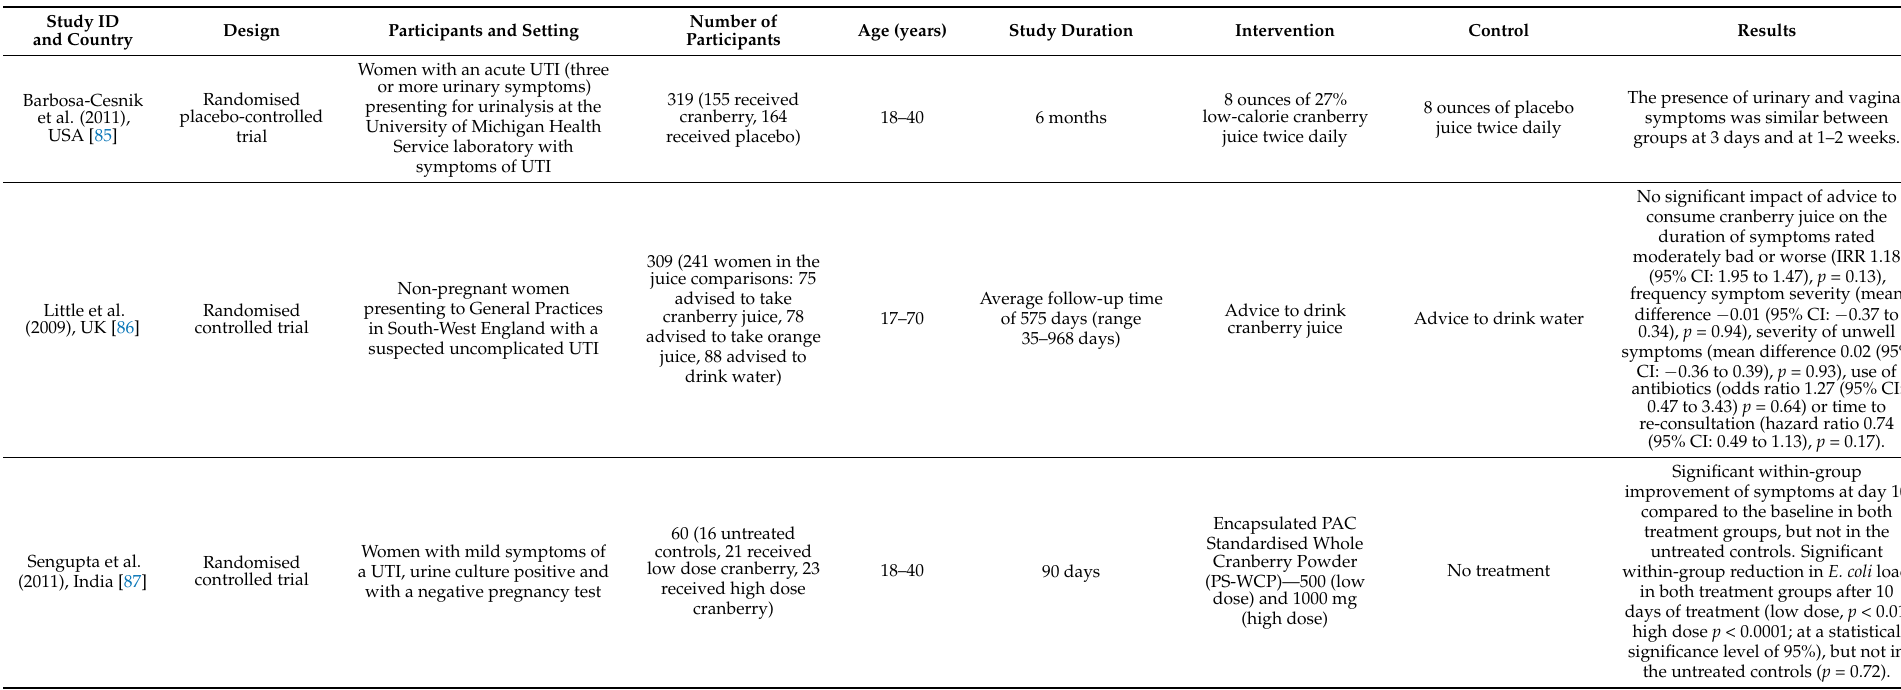
Table 1. Characteristics of included studies and key